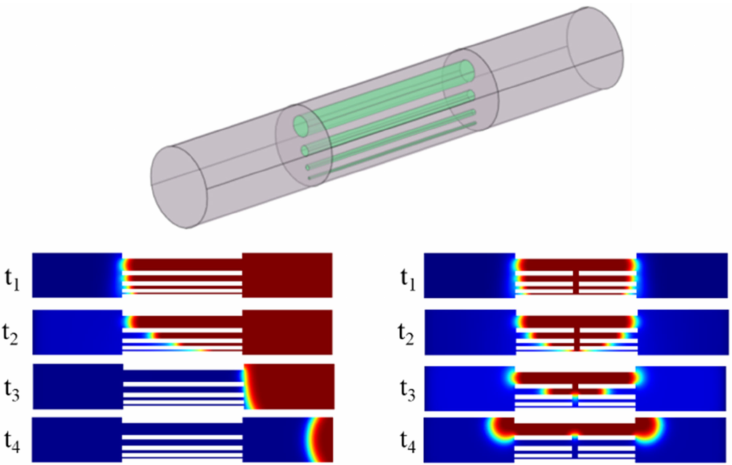
Figure 9. Schematic diagram of forward and reverse imbibition (blue area represents water and red area represents oil).